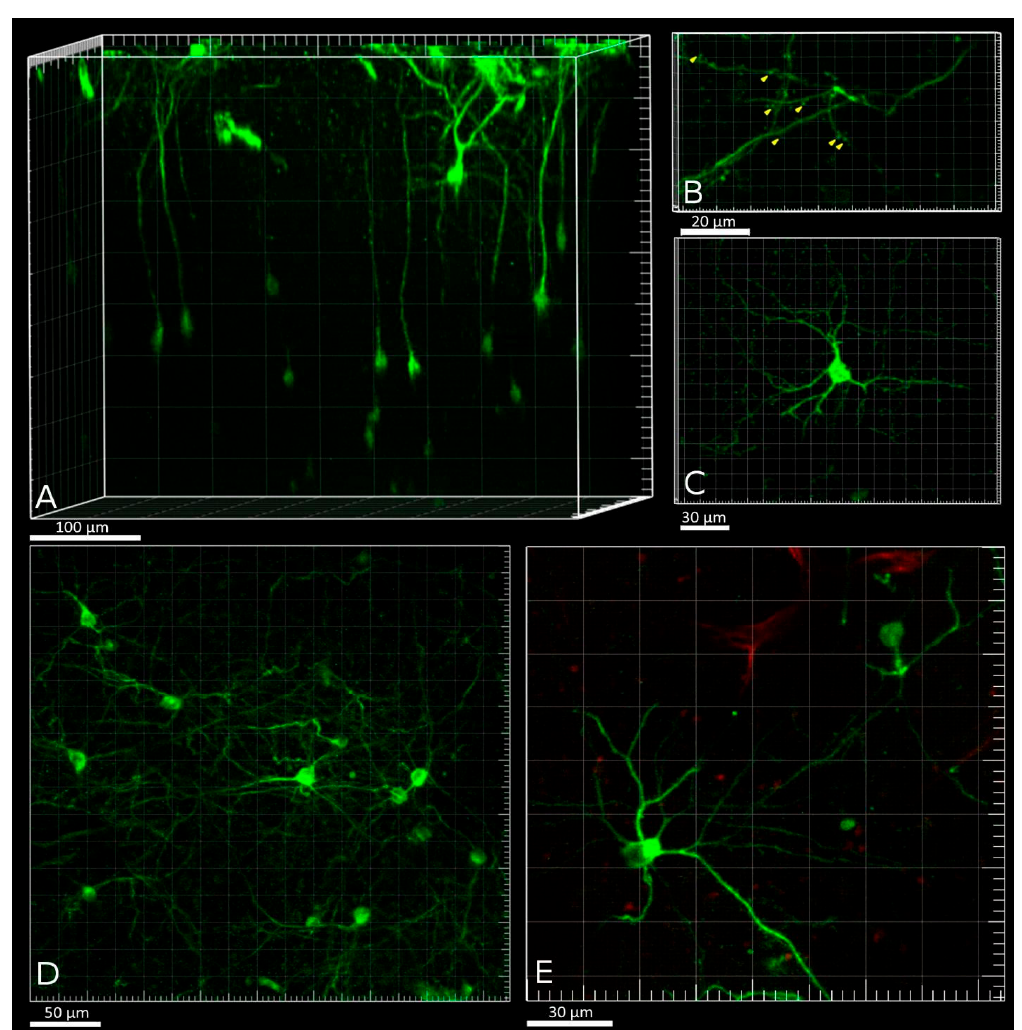
Figure 6. ( A ) 3D reconstruction of GCaMP-expressing neurons in the PtA. ( B ) Dendritic shafts and spines (tagging by yellow arrows) at cortical layer 1 of the PtA. ( C – E ) Examples of GCaMP-positive neurons in cortical layer 2 of the PtA. Green channel: GCaMP signal, red channel: autofluorescence of collagen at the brain surface.